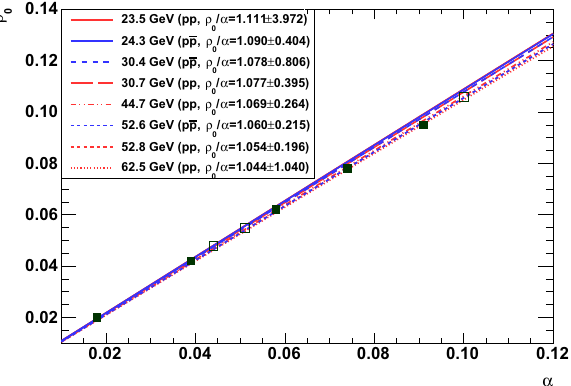
Fig. 31 Linearity between the ratio ρ 0 and the α parameter of the ReBB model in the few tens of GeV energy region calculated from the trends of the scale parameters, R q ( s ) , R d ( s ) , R qd ( s ) , corresponding to Fig. 30a–c. The square shaped markers in the figure are positioned to the experimentally measured ρ 0 values. In the ISR energy range, the ratio ρ 0 ( s )/α( s ) is in an excellent agreement with the analytic approxi- mations given by Eq. (B.7) of Appendix B, as also illustrated on Fig. 32